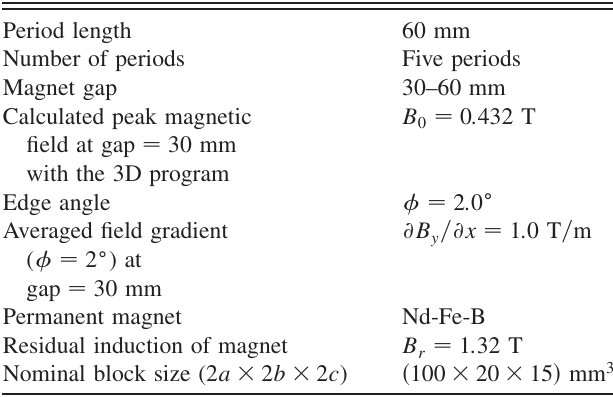
TABLE I. Main parameters of the experimental model of the EF wiggler.